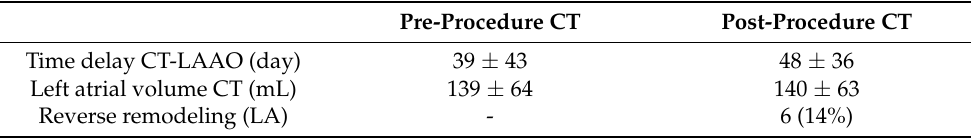
Table 3. Pre-procedural and post-procedural characteristics on